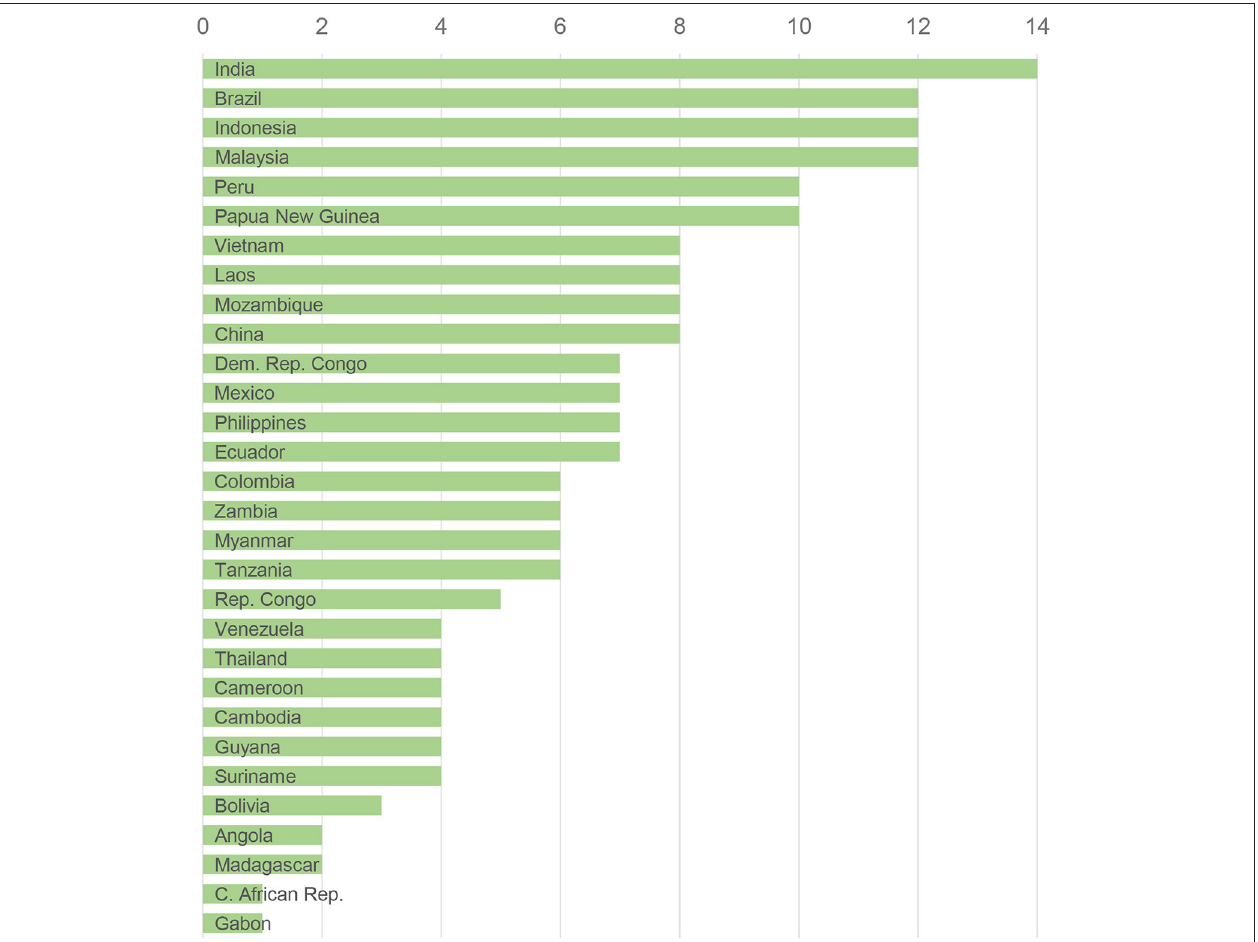
Frontiers in Forests and Global Change |